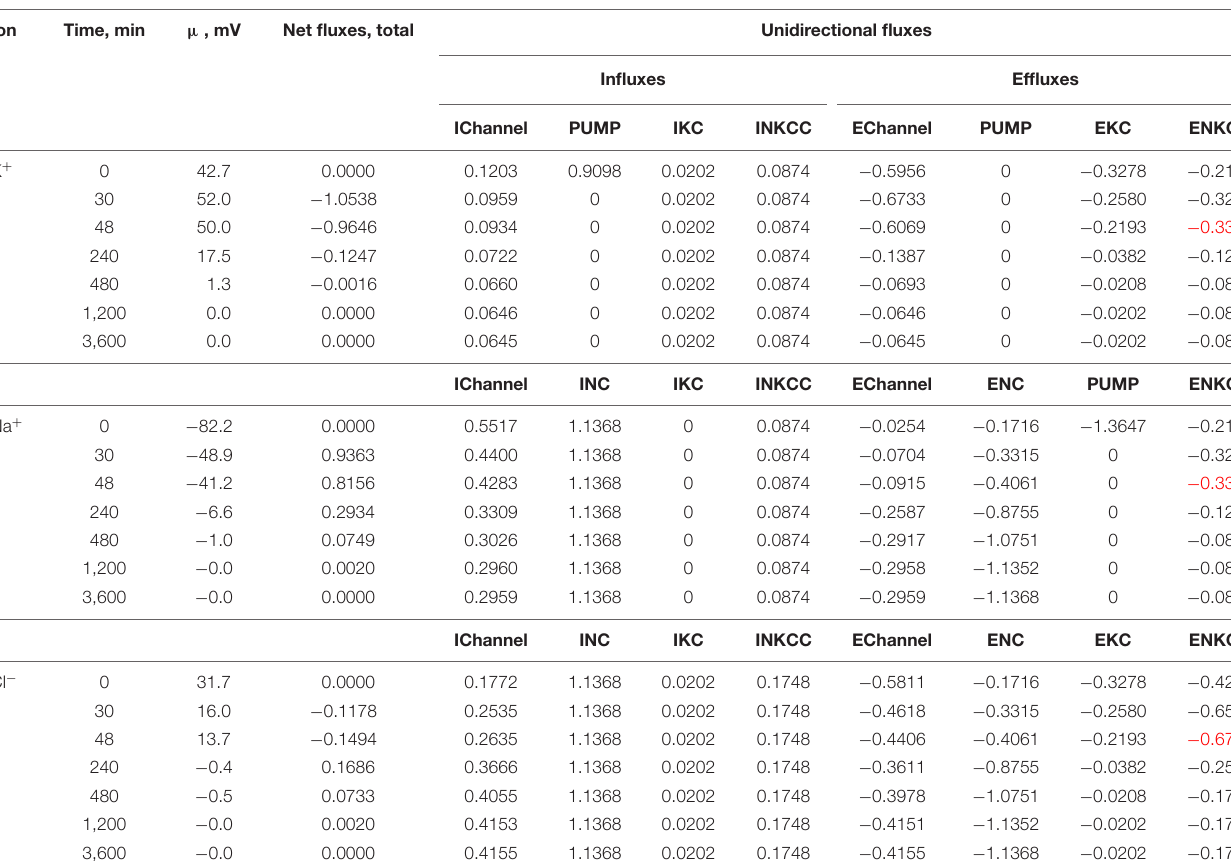
TABLE 3 | Dynamics of the net and unidirectional K + , Na + , and Cl − fluxes after stopping the pump calculated for the model with all main cotransporters at the unchanged-over-time parameters as in U937 cells, equilibrated with the standard RPMI medium: [Na] o 140, [K] o 5.8, [Cl] o 116 mM, and [B] o 48.2 mM. Ion Time, min